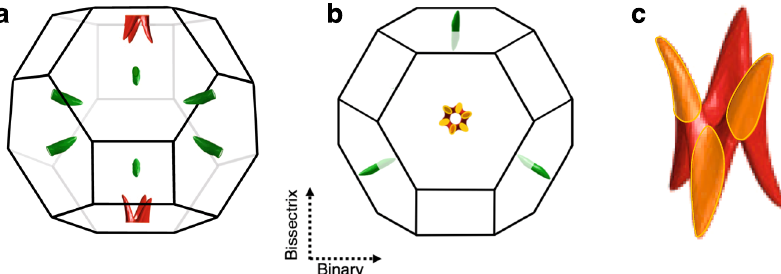
Fig. 2 Fermi surface and the Brillouin zone of antimony (Sb). a The Fermi surface consists of electron pockets (in green) and hole pockets (in red). All pockets are located at zone boundaries and have a mirror counterpart due to the inversion symmetry. The Brillouin zone of the A7 crystal structure, nearly a truncated cuboctahedron, is shown by black solid lines. b Projection to the trigonal plane. c The Fermi surface of holes centered at the T-point. This structure, dubbed ZONY 23 , consists of six interconnected pockets (shown in orange). Table 1 Details of the samples.